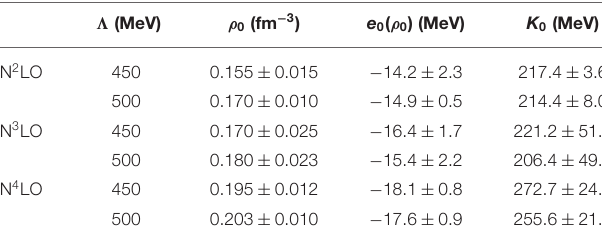
TABLE 3 | Saturation properties from N 2 LO to N 3 LO and two values of the